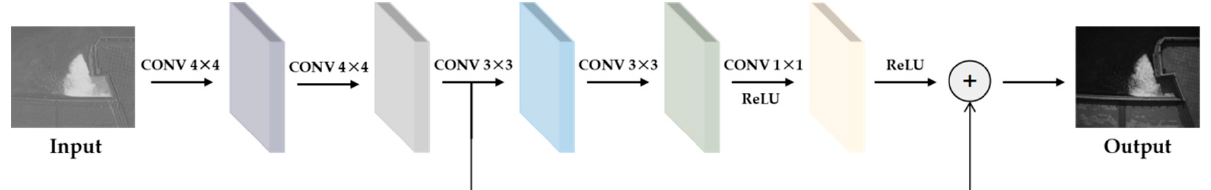
Figure 2. Structure of feature-enhancement module.